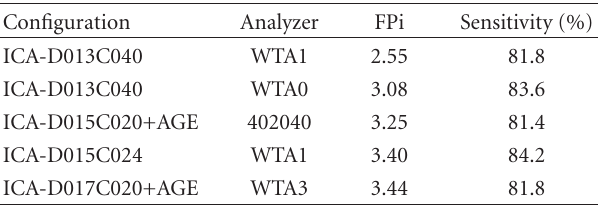
Table 1: Performance results on the BCRP CALC 1 subset of the five system configurations that generate the lowest false positives per image and provide a sensitivity higher than 80%.